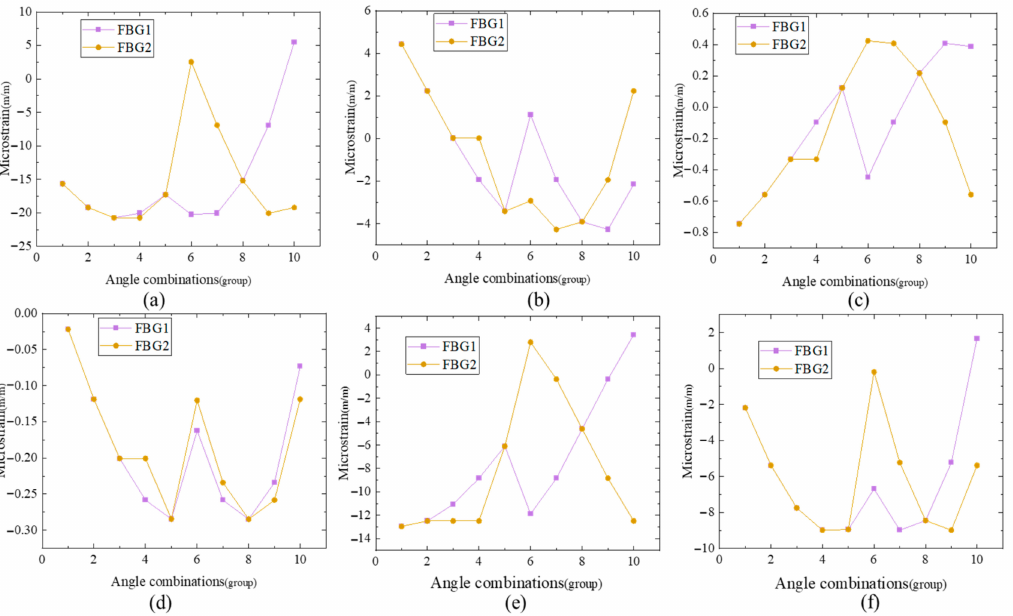
Figure 5. Double FBG strain variation diagram of measuring point 11: ( a ) Load loading mode 1; ( b ) Load loading mode 2; ( c ) Load loading mode 3; ( d ) Load loading mode 4; ( e ) Load loading mode 5; ( f ) Load loading mode